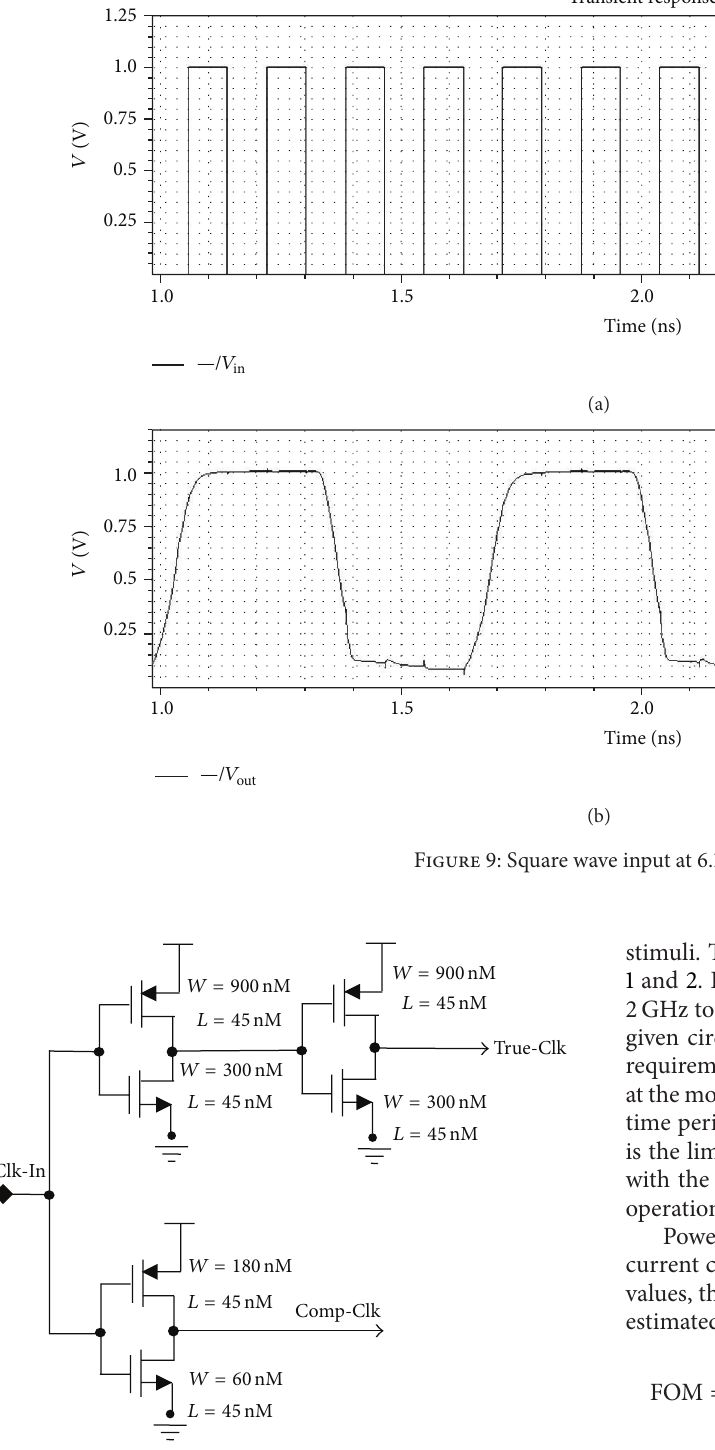
Figure 10: Skew reduction block with aspect